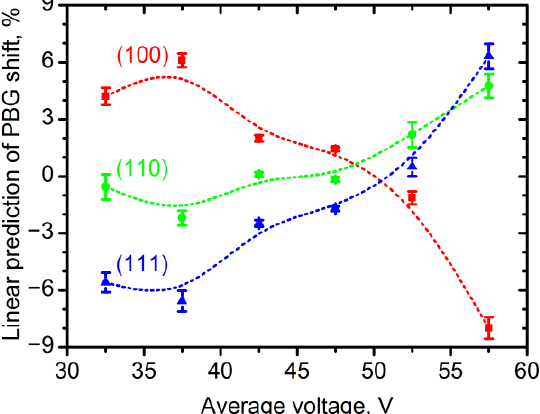
Figure 5. Linear prediction of PBG shift at low index surfaces of Al substrate versus the average voltage used for the synthesis of photonic crystals. The dashed lines are a guide for the eye.